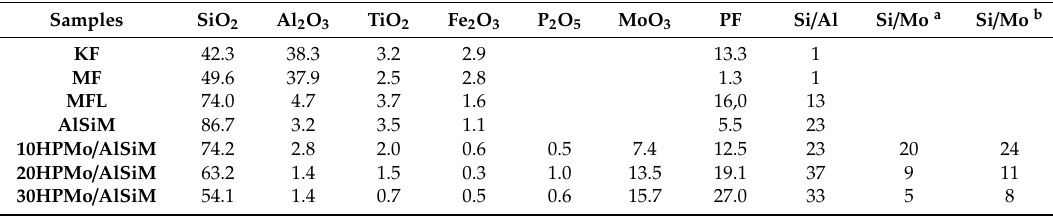
Table 1. Chemical composition of precursors, AlSiM and (10, 20 and 30) HPMo/AlSiM through X-ray fluorescence (XRF).